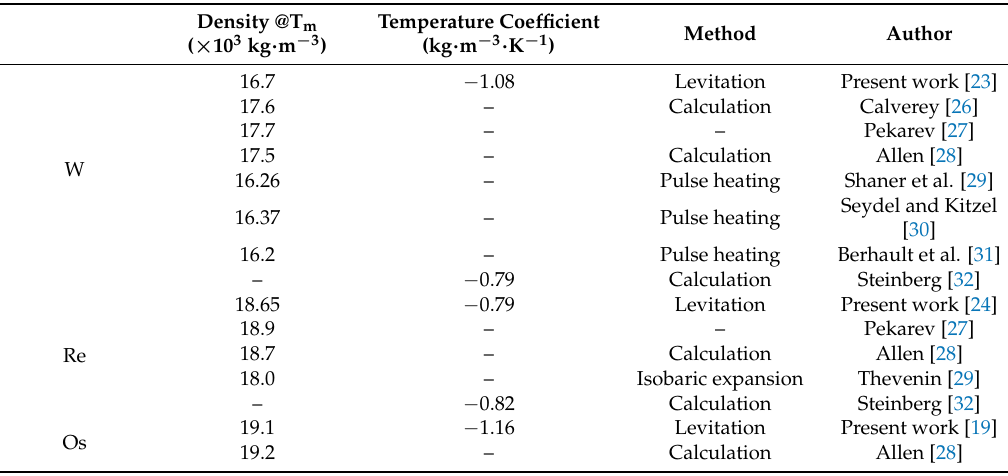
Figure 9. Density of W [23], Re [24], and Os [19] versus temperature. Table 2. Measured density data of W, Re and Os.